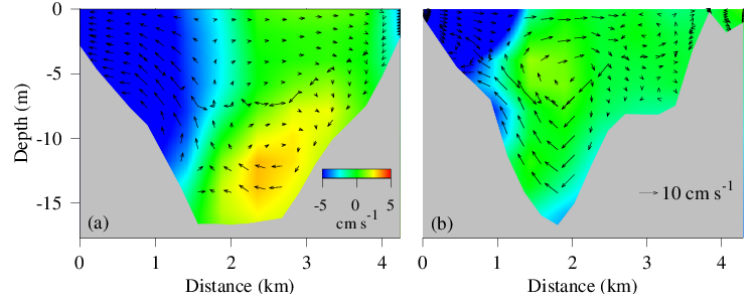
Figure 12. Along channel (color, blue downstream, red upstream) and cross-channel (arrows) at the transect ( a ) in the mesohaline open area and ( b ) at the meandering section where hypoxia and buoyancy are discontinued (see Figure 11 for location).